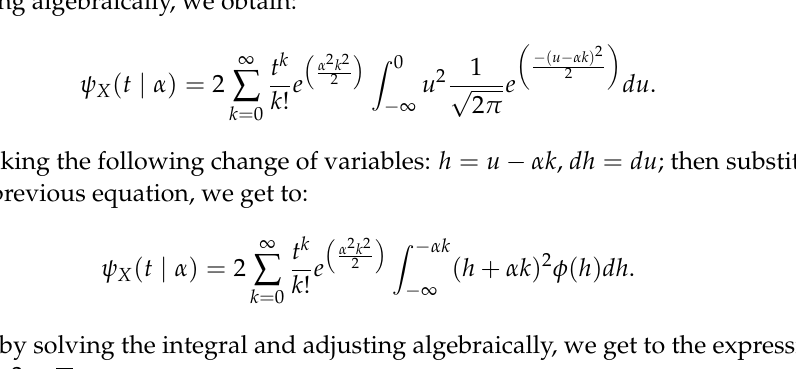
Algorithm 1 Random number generation from the AU ( α )